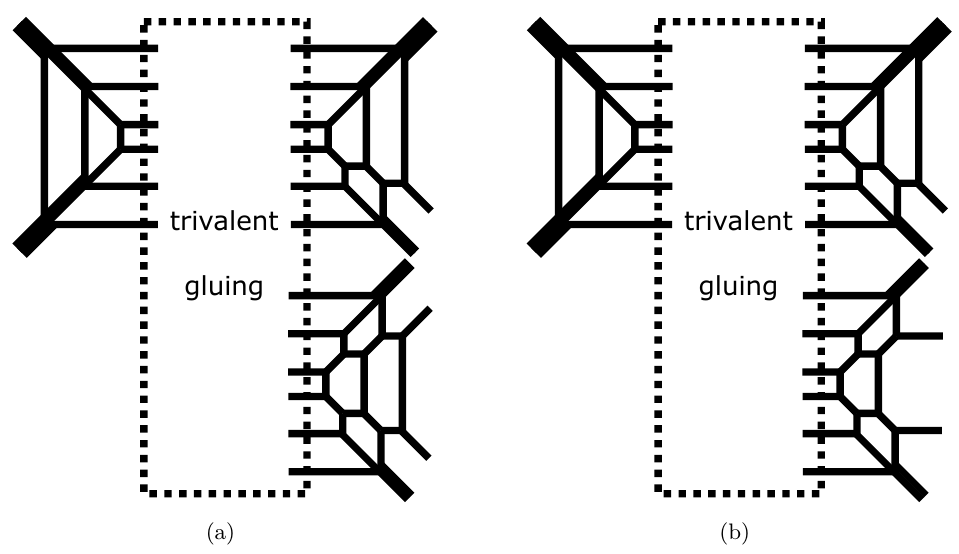
Figure 32. (a). The web diagram for the geometry f (1) 5d F 4 gauge theory with 3 flavors.